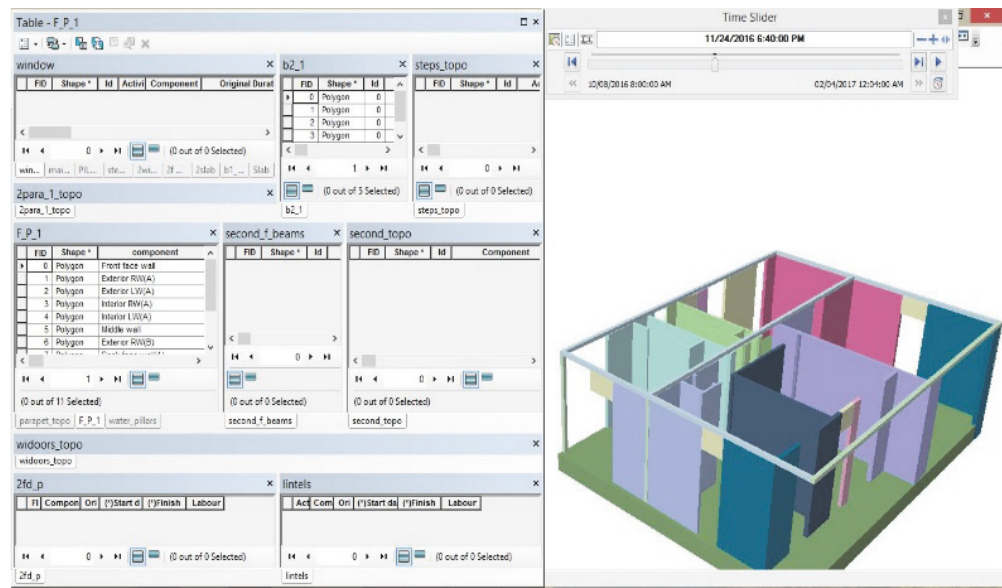
Figure 6: Extrusion of first floor